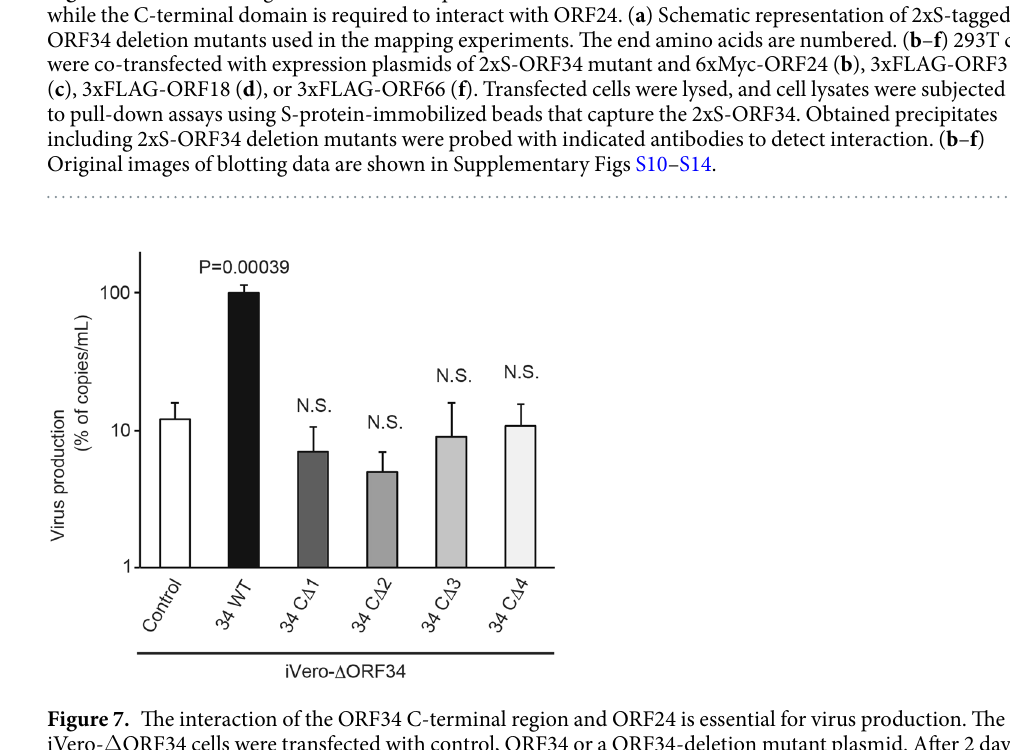
data indicate that the central region of ORF34 recruits transcription associated factors, and the C-terminal region plays a crucial role in the recruitment of this complex to ORF24, which binds to the L gene promoter of viral DNA. Thus, full length ORF34 is essential for L gene expression and viral production.